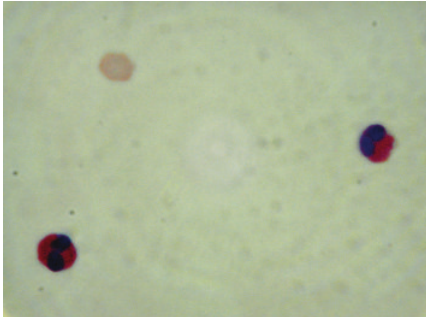
Figure 3: This high-power oil immersion view of ascitic fluid shows two degenerating eosinophils containing eosinophilic granules and bilobed nuclei (H&E stain; magnification 1000 × ).